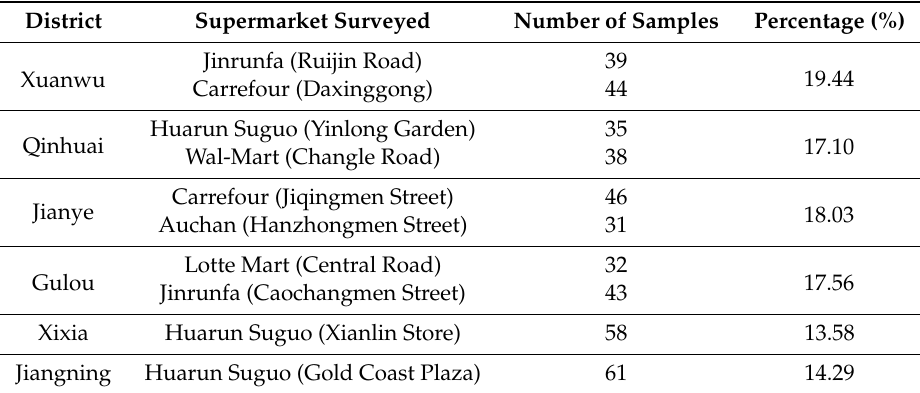
Table 1. Regional distribution of